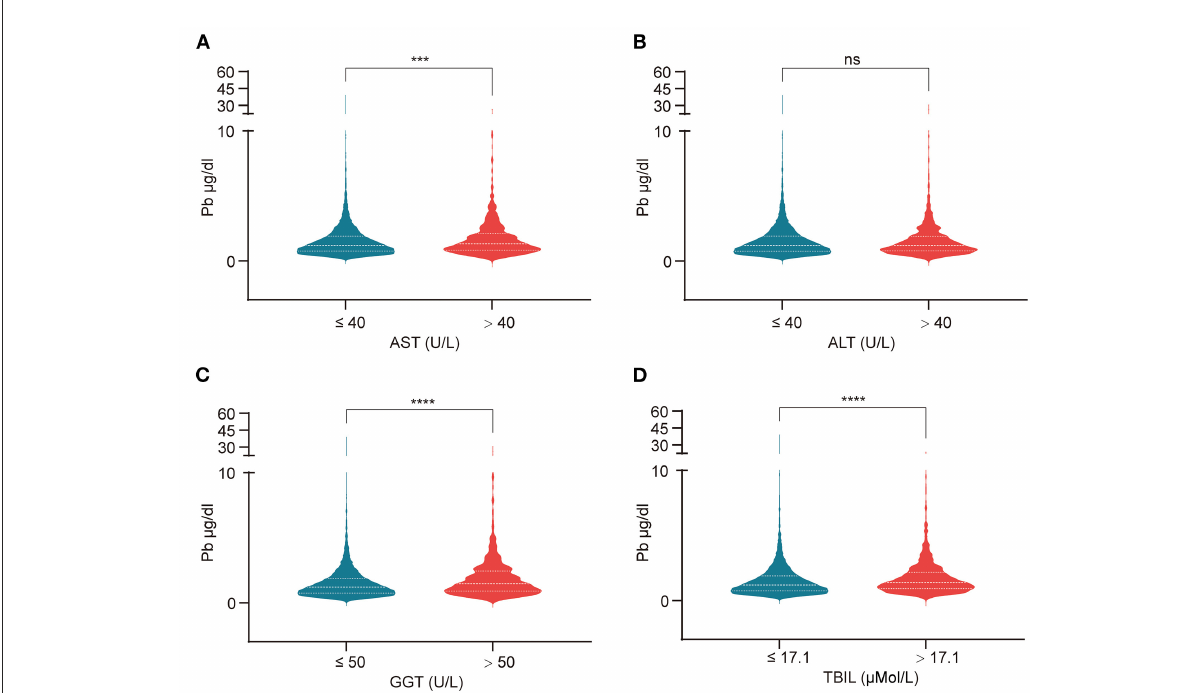
FIGURE2 The violin plots reflect the effect of lead exposure on liver function. (A) AST > 40 U/L group had higher blood lead concentration; (B) The effect of lead exposure on ALT was not significant; (C) GGT > 50 U/L group had higher blood lead concentration; (D) TBIL > 17.1 µ Mol/L group